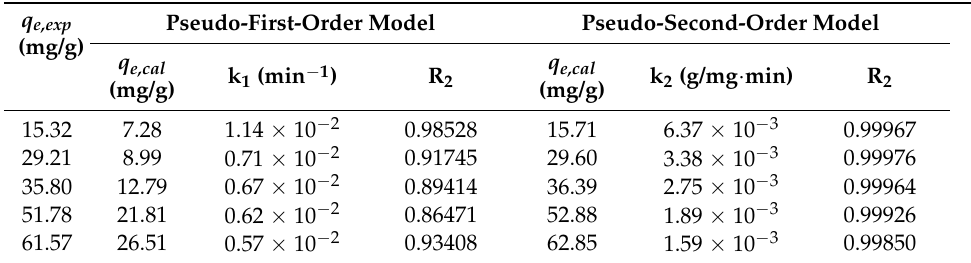
Table 1. Fitting parameters of the first-order and second-order adsorption